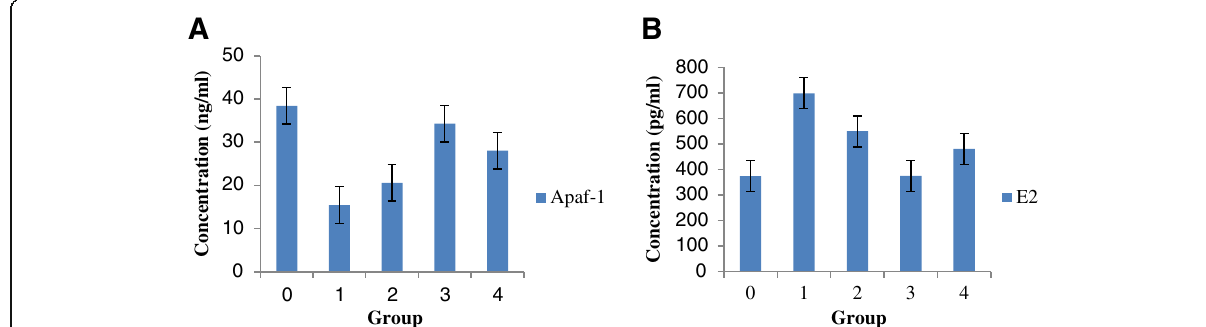
Fig. 4 The serum level concentration of Apaf-1 (ng/ml) (Fig. 4 a ) and E2 (pg/ml) (Fig. 4 b ) in the rats of TH treated groups compared to the rats of normal and negative controls. Data are expressed as median interquartile range (IqR) using Kruskal-Wallis test. Values are statistically significant, p